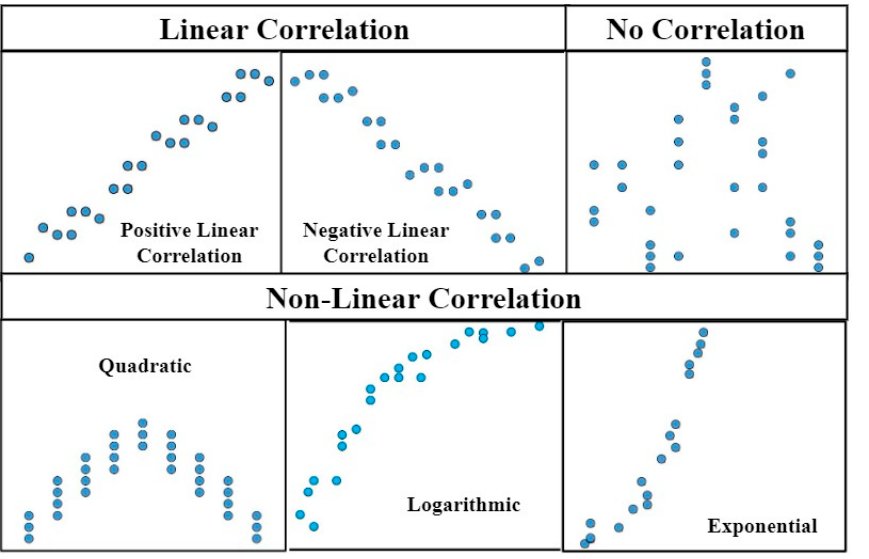
Table 1. Regression expression for different